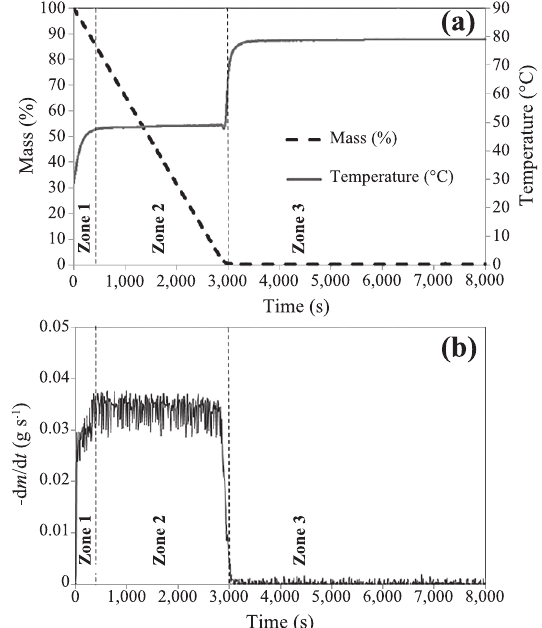
Fig. 14 Water drying in the convective dryer at 80 °C. Varia- tion of (a) the mass and the temperature of the cotton surface, and (b) the drying